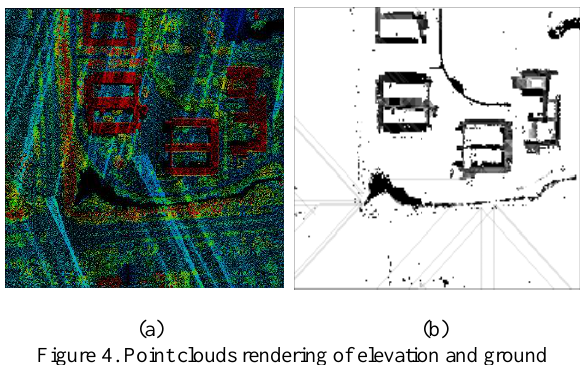
Figure 4. Point clouds rendering of elevation and ground